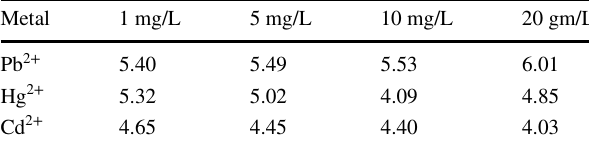
Table 2 pH of the monometal solution